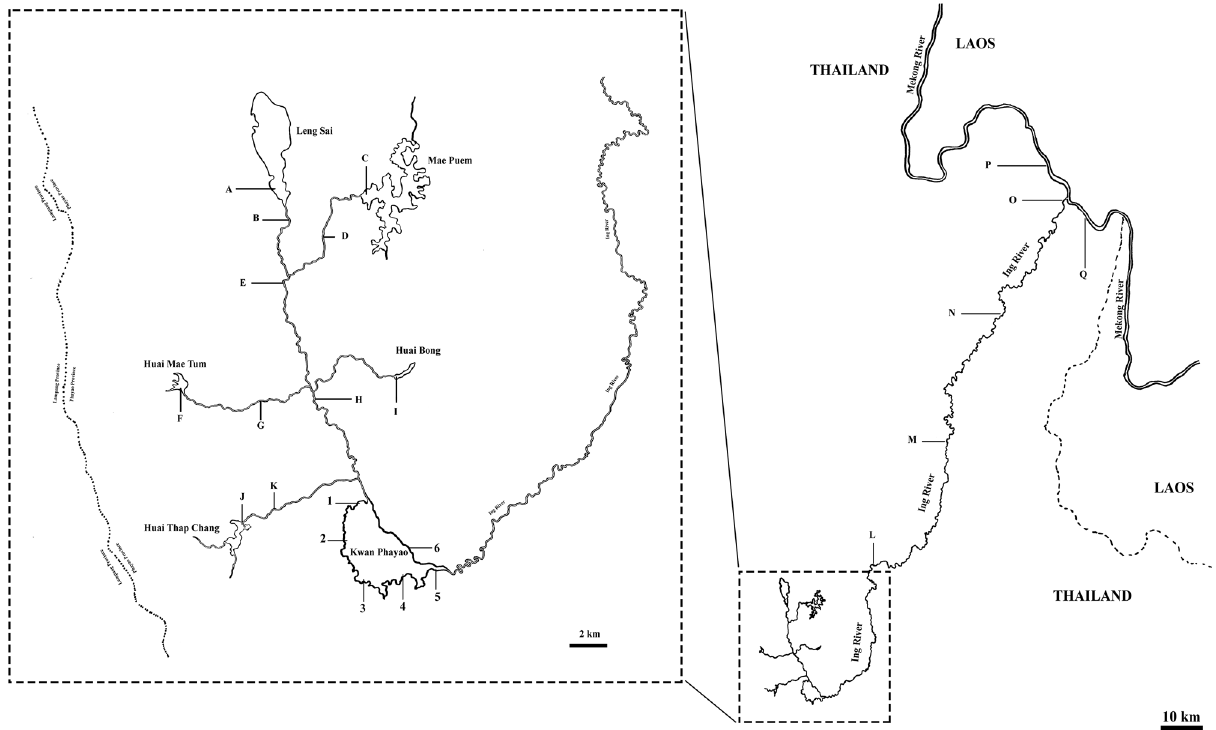
Figure 1. Map showing sampling sites. 1–6 water collecting sites in Kwan Phayao, A–K where water flowed into Kwan Phayao and L–Q where water flowed out of Kwan